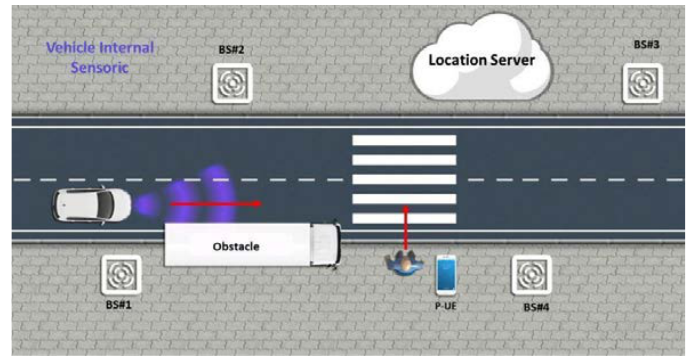
Figure 3. Network assisted vulnerable road user protection use